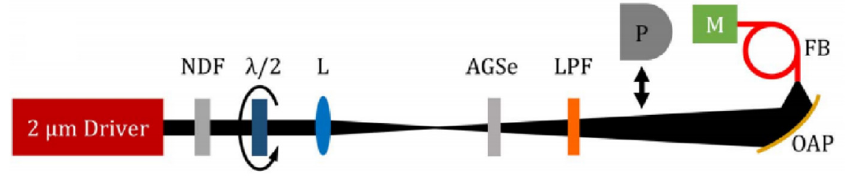
with permission from [62].